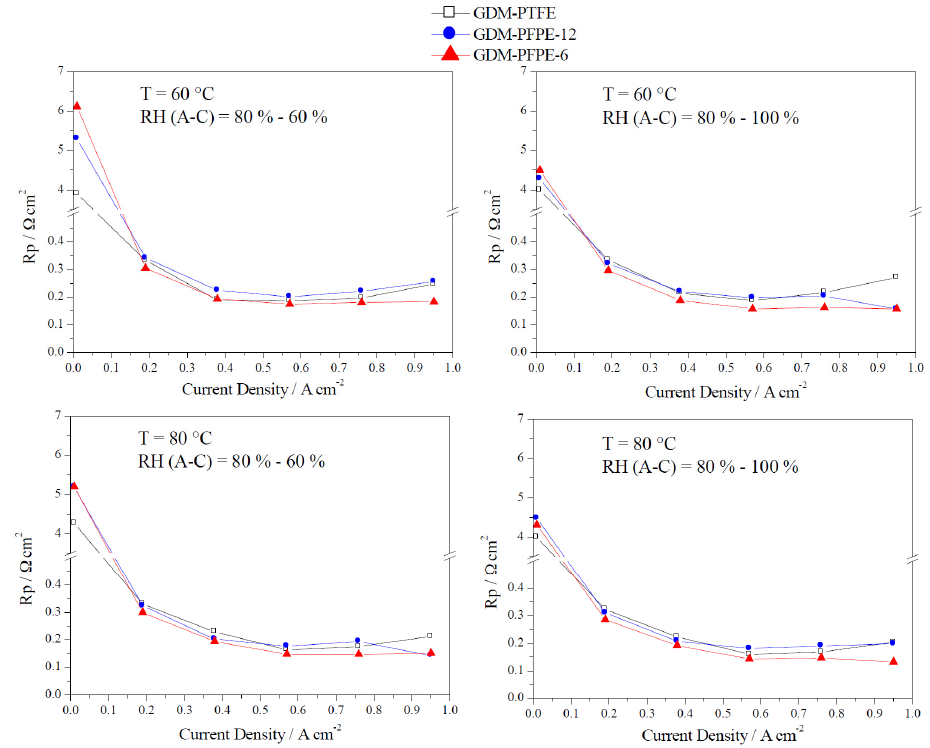
Figure 7. Polarization resistance trend as a function of current density: fitting results comparisons at different operating